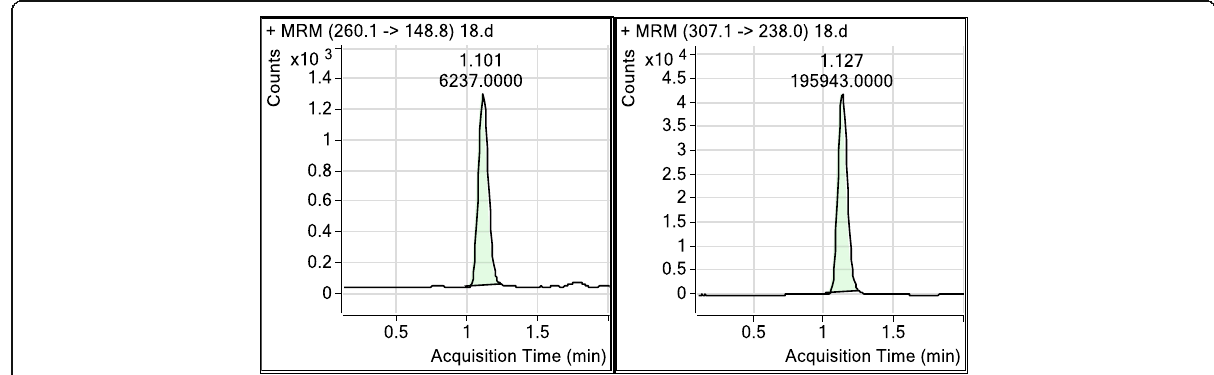
Fig. 2 Representative chromatogram of blank plasma sample spiked with lenalidomide at the LLOQ of 10 ng/mL and I.S (1000